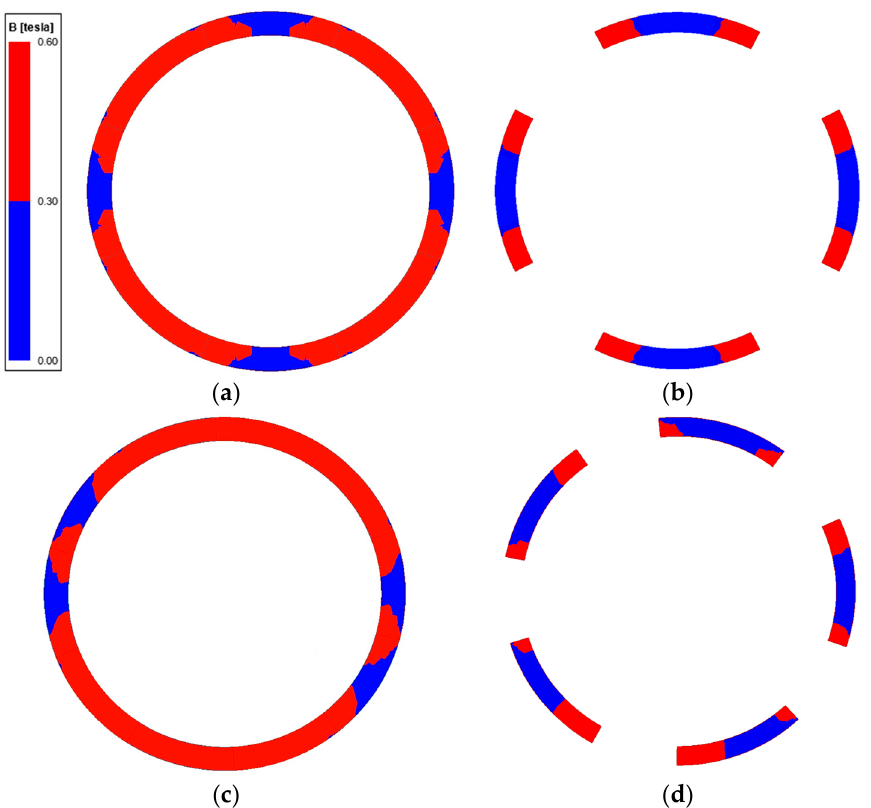
Figure 25. Demagnetization area distribution in magnets under I d = − 50A. ( a ) 12s8p-SPM. ( b ) 12s8p-